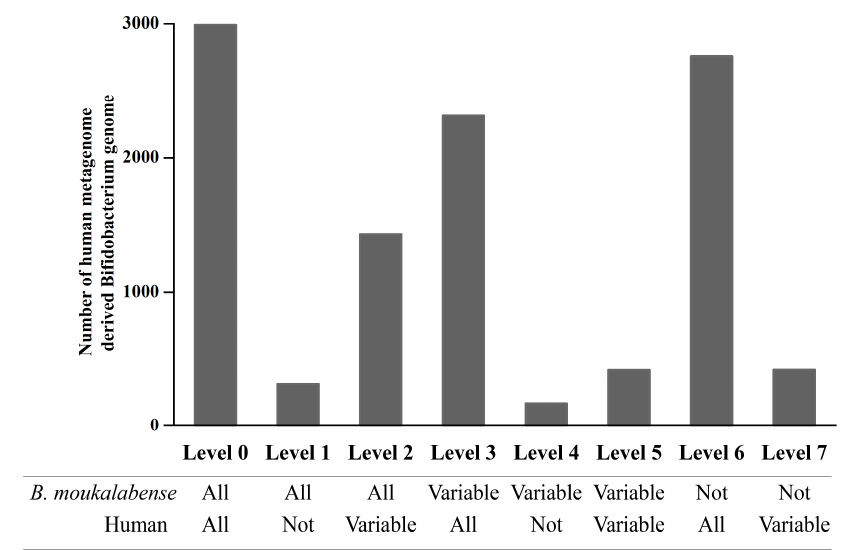
Figure 2. Numbers of shared orthologs derived from genomes of Bifidobacterium moukalabense and meta-bifidobacterial genomes reconstructed from human metagenome data. The 3973 draft Bifidobacterium genomes were derived from 9428 human metagenome samples (37). Protein coding genes (6,105,571 genes) from the 3973 draft Bifidobacterium genomes were predicted. For details, see text.